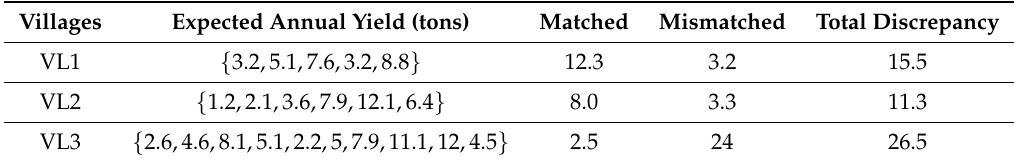
Table 1. Analysis of Optimal